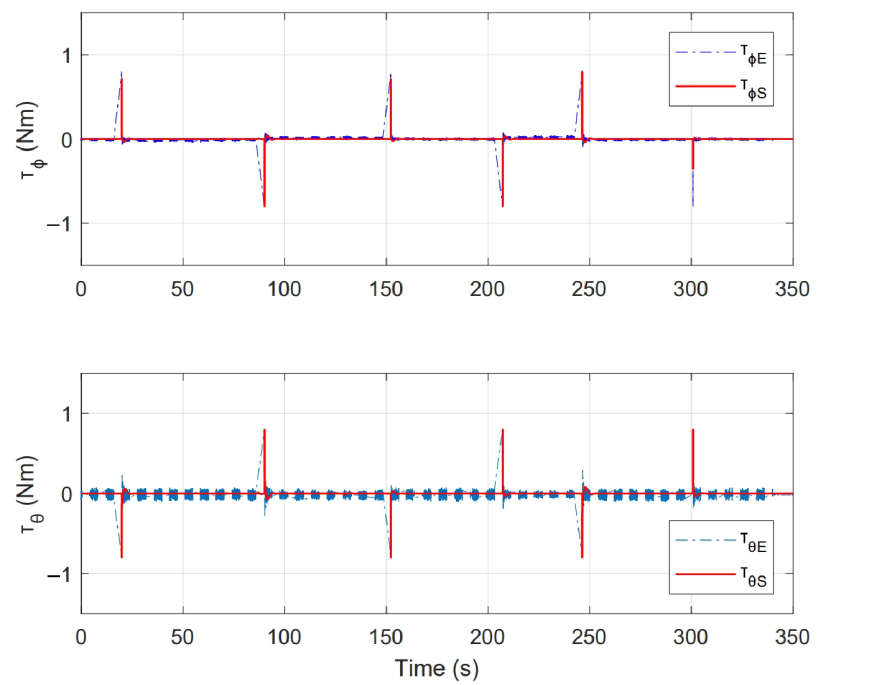
Figure 23. Control inputs presented in PID control